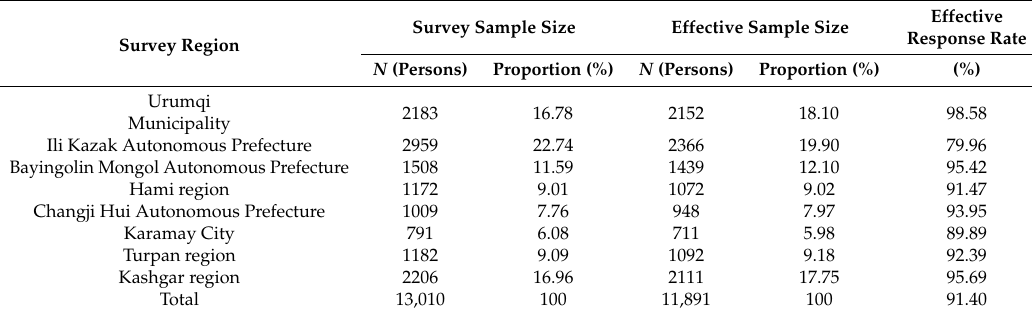
Table 1. Regional distribution of the